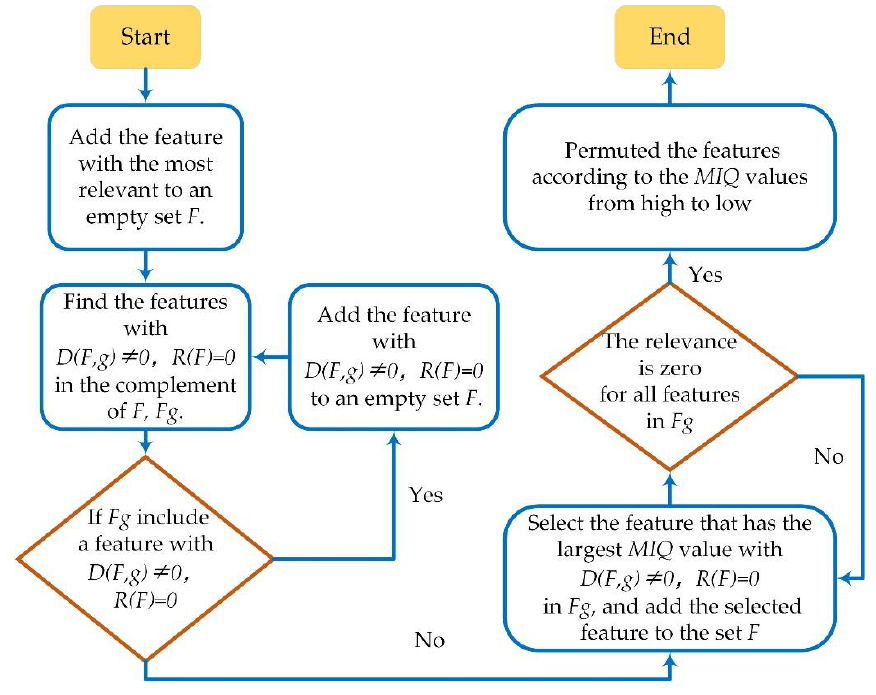
Figure 4. The computation process of mRMR to select the effective features.